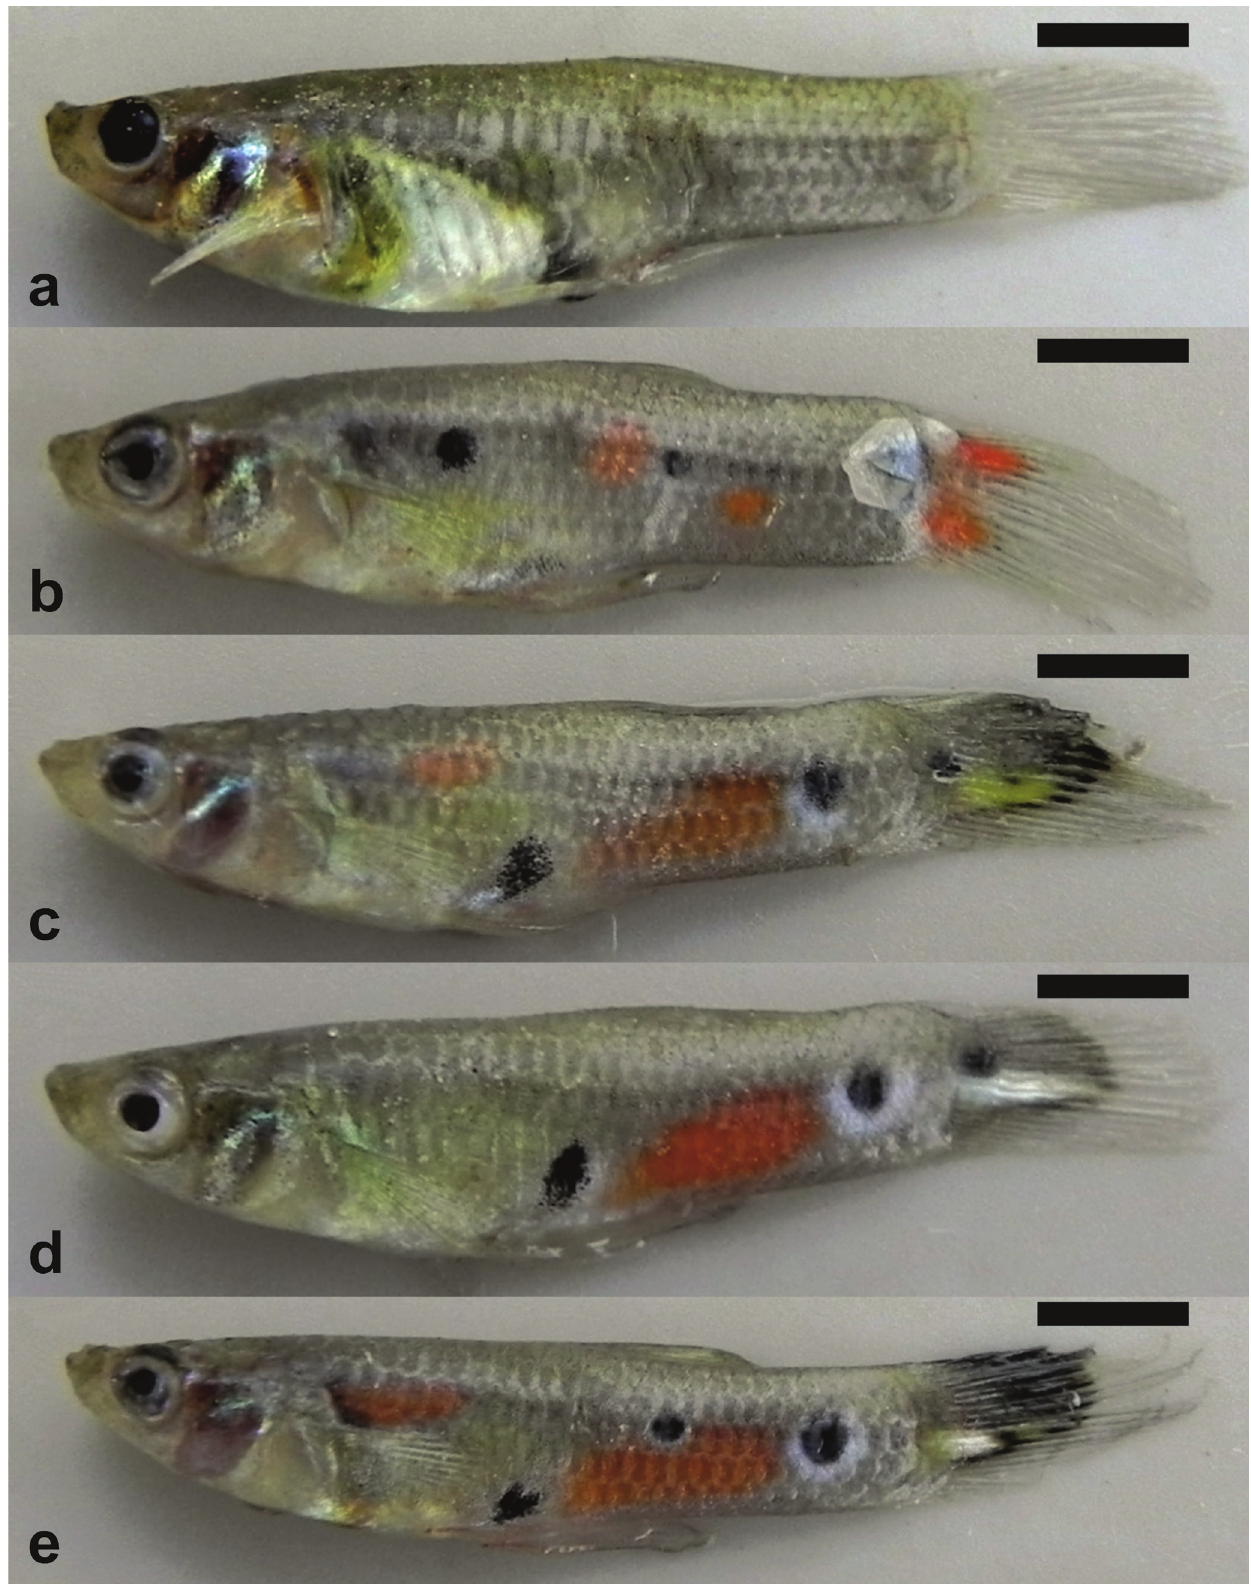
Fig. 2. Selected collected specimens of Poecilia reticulata in the lower Paraguay River. a . female: UNMDP 3687, 22.1 mm SL; b . male 1: UNMDP 3693, 15.9 mm SL; c . male 2: UNMDP 3694, 15.9 mm SL; d . male 3: UNMDP 3692, 16.9 mm SL; e . male 4: UNMDP 3691, 16.8 mm SL. Scale bars: 3